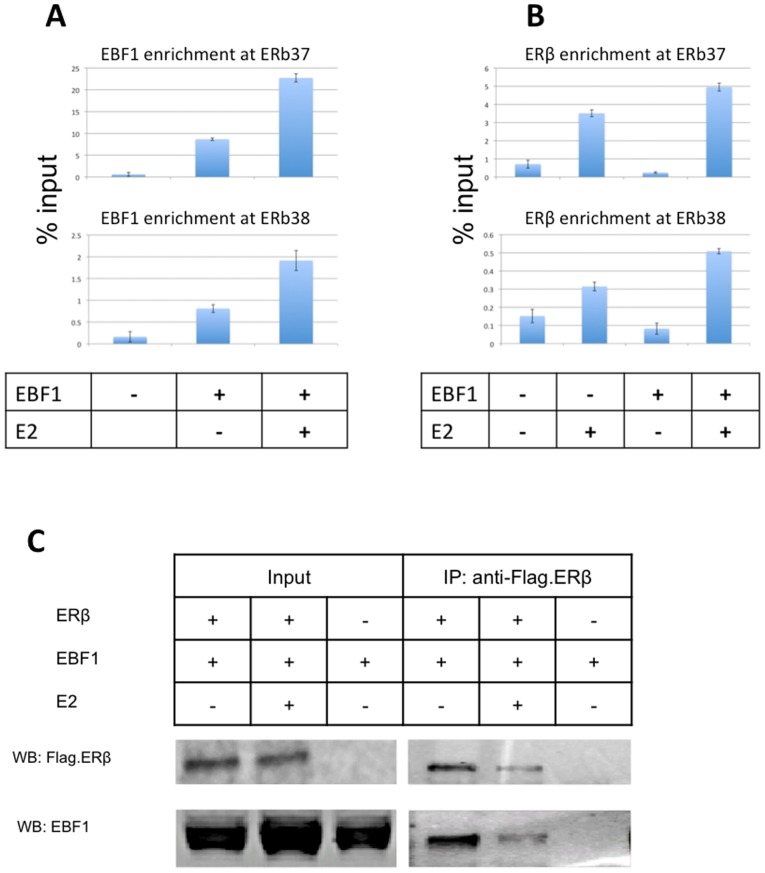
The association between ERβ and EBF1.C4–12/Flag.ERβ cells were transfected withV5-tagged EBF1 and incubated for 1 hr with 10 nM E2. Cells were then treated with 1% formaldehyde and processed by ChIP assay using (A) anti-V5 antibody and (B) anti-Flag M2 antibody. (C) C4–12/Flag.ERβ cells were transfected with V5-tagged EBF1, treated with 10 nM E2, lysed and subjected to co-immunoprecipitation using anti-Flag M2 antibody to immunoprecipitate complexes containing Flag.ERβ. Anti-Flag M2 antibody and anti-V5 antibody were used on Western blots to detect V5.EBF1 and Flag.ERβ, respectively.